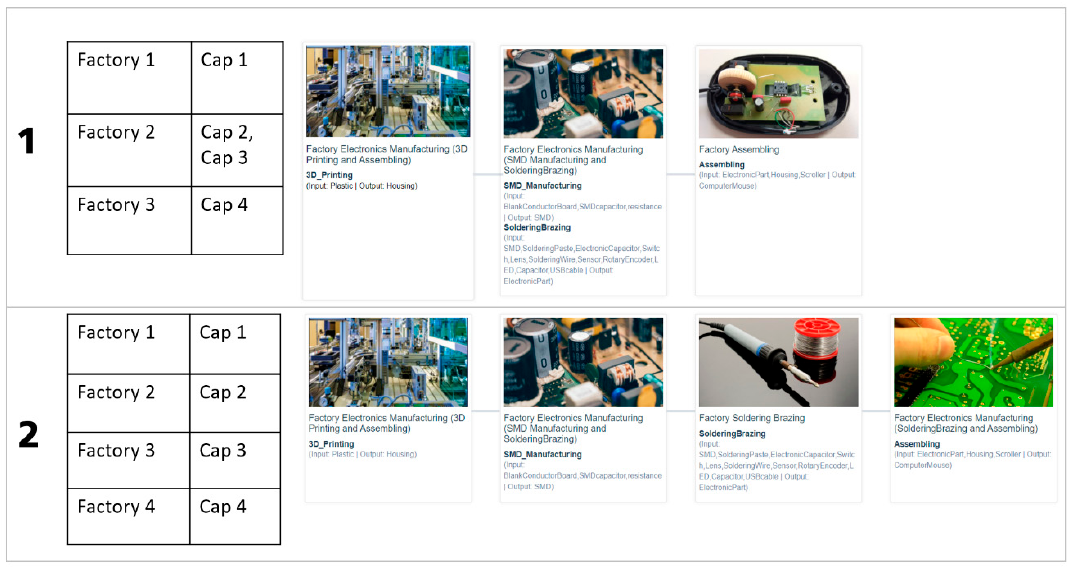
Figure 12. Search result—search for electronics manufacturing.